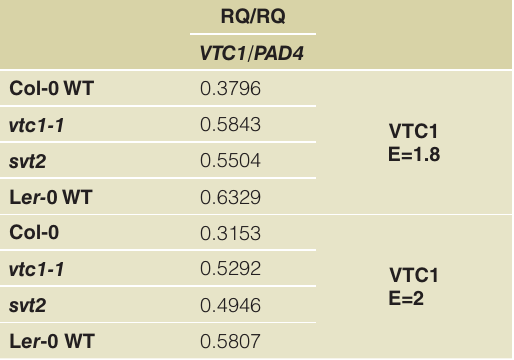
Table 2. Quantitative PCR to verify that VTC1 is a single copy gene in Col-0 and L er -0 wild types and vtc1-1 and svt2 mutants. Quantitative PCR was performed as described in Materials and Methods. The PAD4 gene is a known single copy gene. Therefore, an RQ/RQ ratio of approximately 1 indicates that VTC1 is present in similar quantity as PAD4, and therefore a single-copy